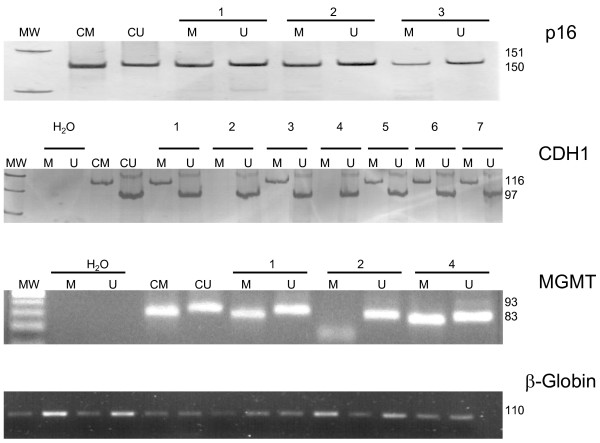
Representative examples of MS-PCR analysis of 82 induced sputum clinical samples. Bisulfite-modified DNA was amplified with specific primers to detect methylated DNA (M) and unmethylated DNA (U); MW: Molecular weight marker; in vitro genomic DNA treated with SssI enzyme used as positive control for methylated genes. (CM); peripheral blood lymphocytes DNA used as a control of unmethylated genes (CU); H20: distilled water used as negative control in the PCR amplification.